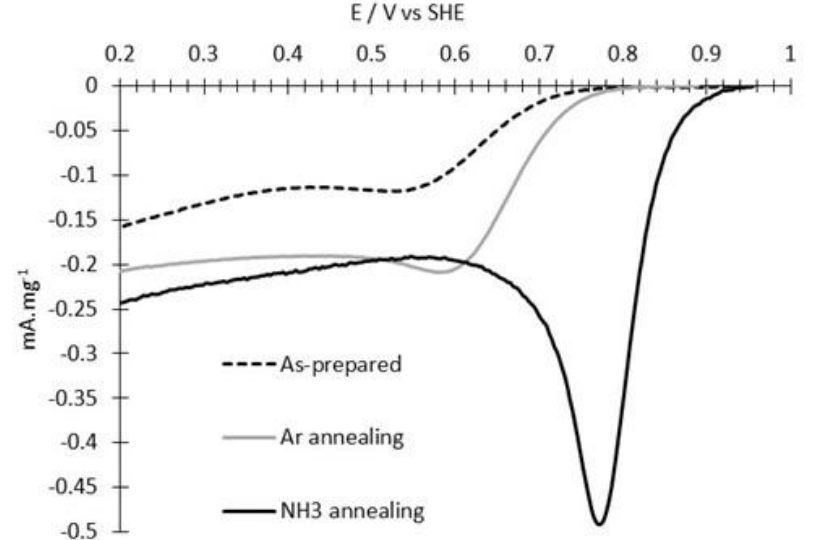
Figure 5. ORR background corrected CVs recorded at 5 mV · s − 1 in HClO 4 1M for the as-formed, and argon and ammonia thermally treated materials, based porous electrodes. The electrode loadings are 3.82, 3.24, and 2.29 mg · cm − 2 , respectively, and the geometrical electrode area is 0.785 cm 2 .